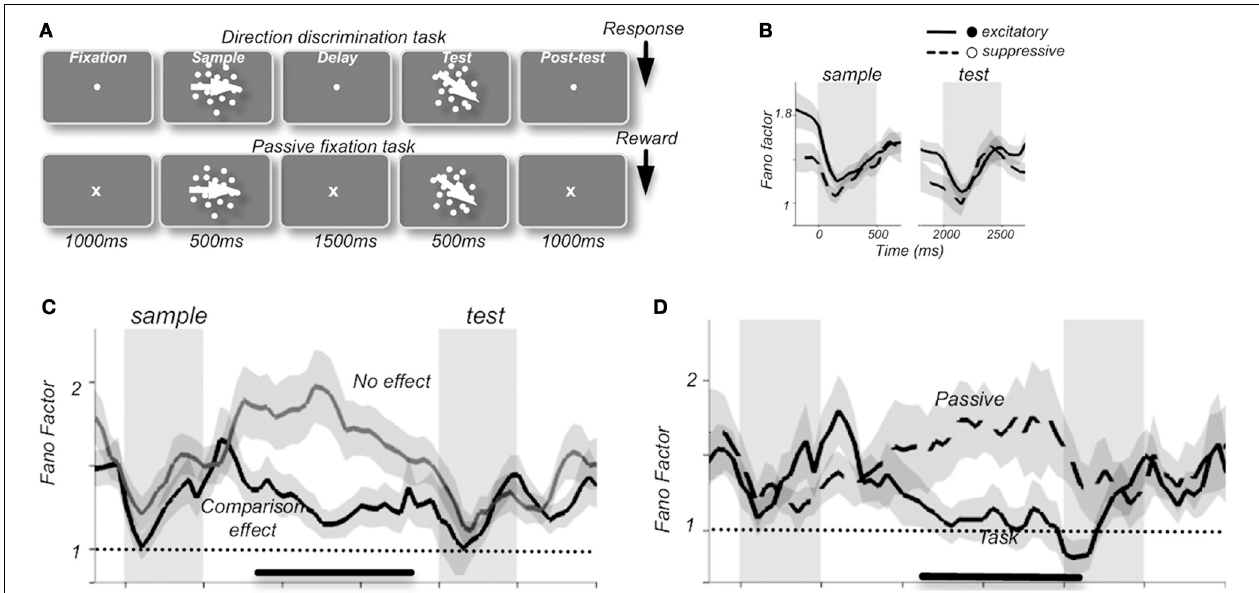
FIGURE 1 | Average Fano factor values change with the components of a motion discrimination task (A) in neuronal recordings from monkey prefrontal cortex. A stimulus-induced drop in FF was present compared to fixation, delay, and post-test periods (B) , along with a preparatory drop in FF preceding the test component in neurons that were able to discriminate between sample and test stimuli (C) . Fano factor values also varied with behavioral performance such that higher variability was observed during